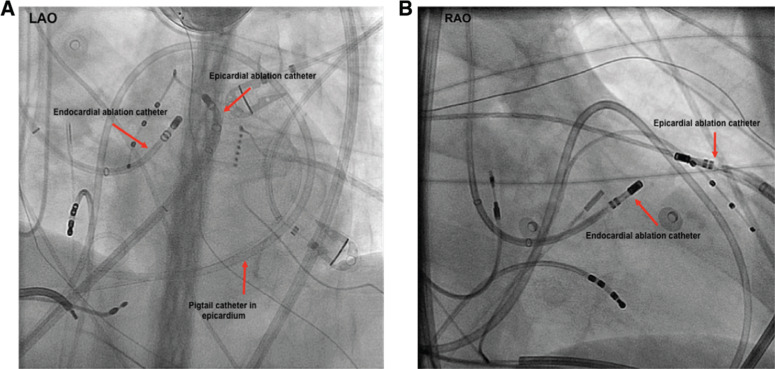
Endocardial–epicardial bipolar ablation configuration. Bipolar ablation across an LV summit midmyocardial circuit may require epicardial access for one of the ablation poles. A and B: Fluoroscopic views (anteroposterior) of two ablation catheters in a bipolar configuration, targeting the LV summit area for this patient. LAO: left anterior oblique; RAO: right anterior oblique.